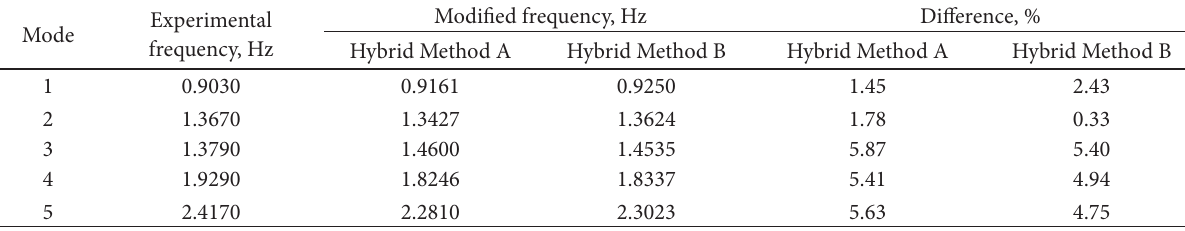
Table 3. The comparison between modified and experimental frequencies Mode